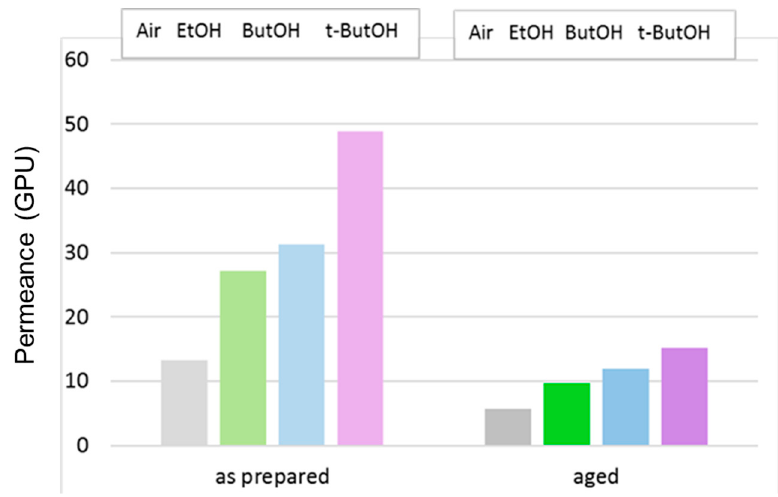
Figure 11. CO 2 permeance in C1 membranes that were dried in air or solvent-exchanged. Tests carried out just after the preparation or after long-term aging.